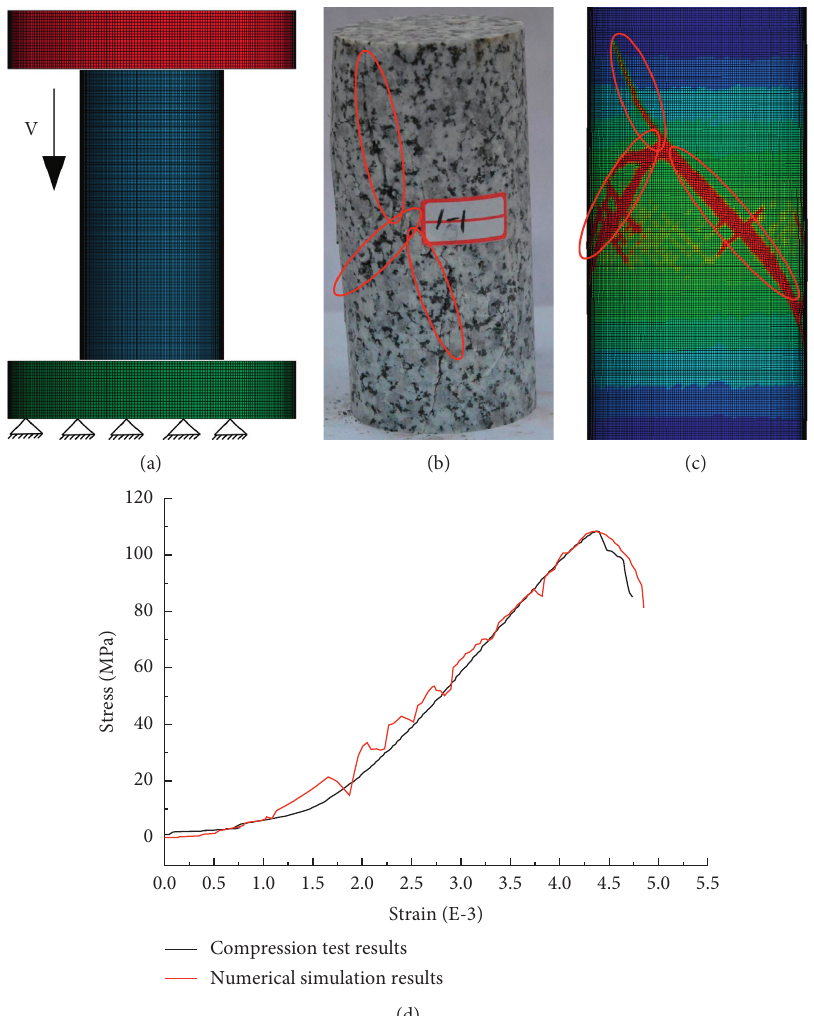
Figure 3: Uniaxial compression test. (a) Numerical simulation uniaxial compression test. (b) Uniaxial compression test results. (c) Numerical simulation uniaxial compression test results. (d) Uniaxial compression test and numerical simulation of stress-strain